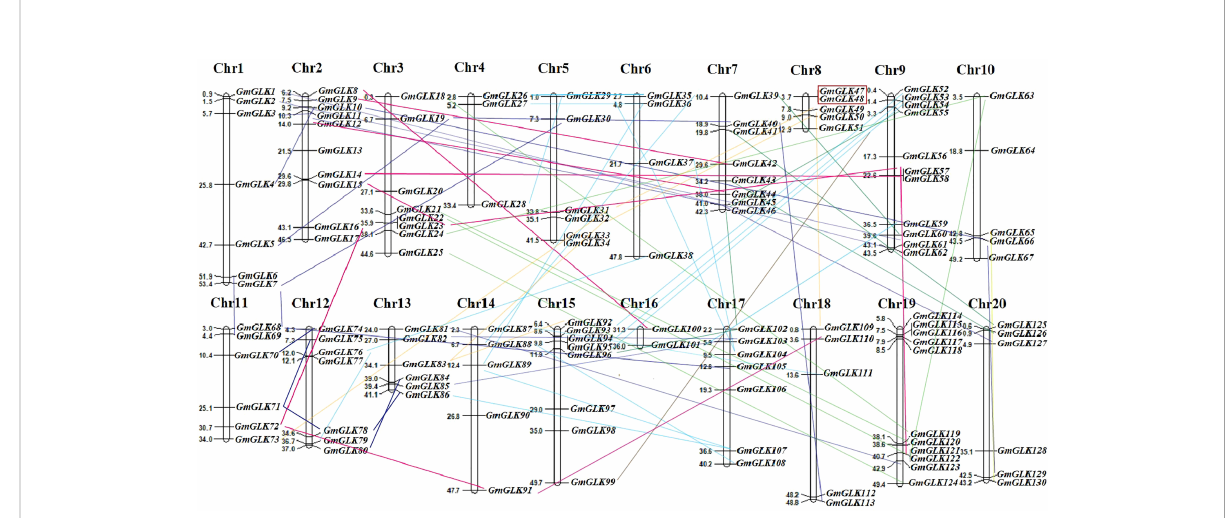
FIGURE 3 The distribution of GmGLK members on 20 soybean chromosomes.The chromosome number (Chr1-Chr20) and the name and physical position (Mb) of GLK members are represented on each chromosome. The segmentally duplicated members are connected with the variant lines, whereas the tandem duplicated members are shown in red color